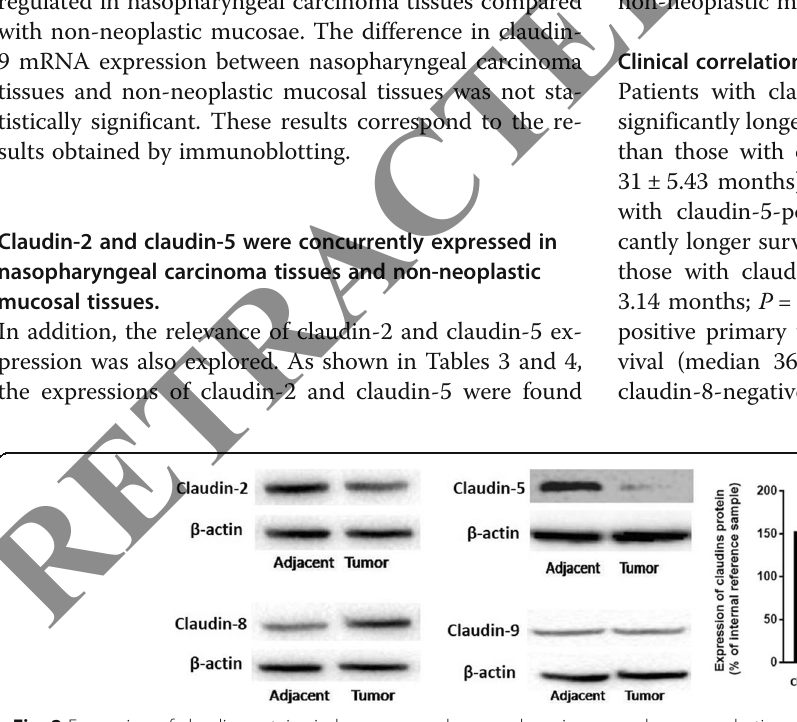
Fig. 2 Expression of claudin proteins in human nasopharyngeal carcinoma and non-neoplastic mucosae. Semiquantitative immunoblotting was used to estimate statistical differences in the expression of claudin proteins in 12 human nasopharyngeal carcinoma tissues and non-neoplastic mucosae. The semiquantitative measurements are expressed as the mean standard deviation and as percent changes from an internal reference sample. a ) claudin-2 expression; b ) claudin-5 expression; c ) claudin-8 expression; d ) claudin-9 expression; e ) Histograms. * P < 0.05 and ** P < 0.01 compared with non-neoplastic